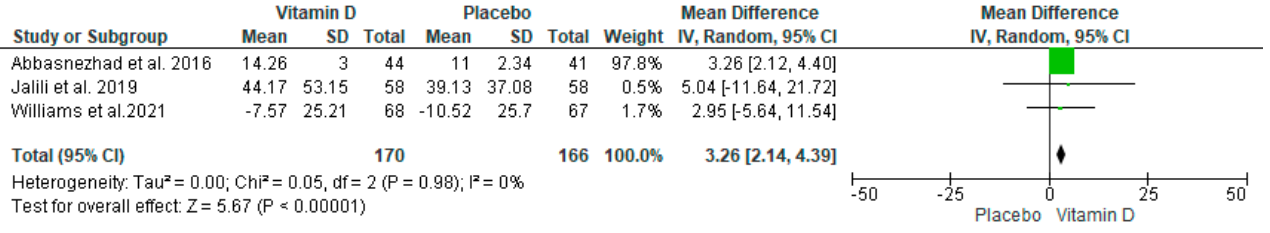
Figure 5. Forest plot of IBS-Qol after exclusion El Amrousy et al. [27]. I2: I-squared; CI: confidence interval.